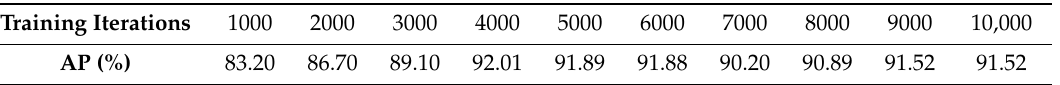
Table 1. Test AP (Average Precision) values of the YOLOv3 network at di ff erent training iterations. Training Iterations